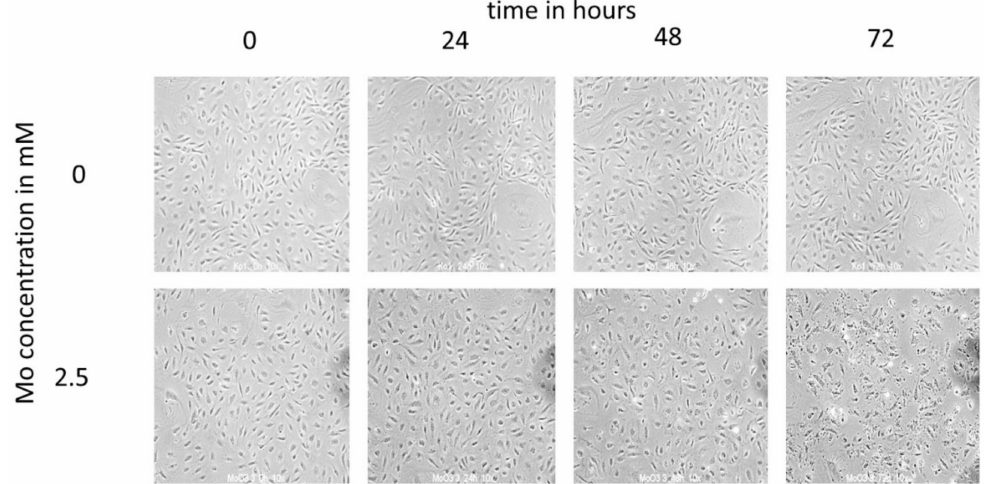
Figure 4. Time series of untreated HCAECs (upper row) and HCAECs treated with 2.5 mM Mo ion concentration (lower row). ECs first showed visible signs of cell death, like increased granularity, after 48 h. Signs of progressed cell death (shrinking, detaching) were observed after 72 h of incubation at this